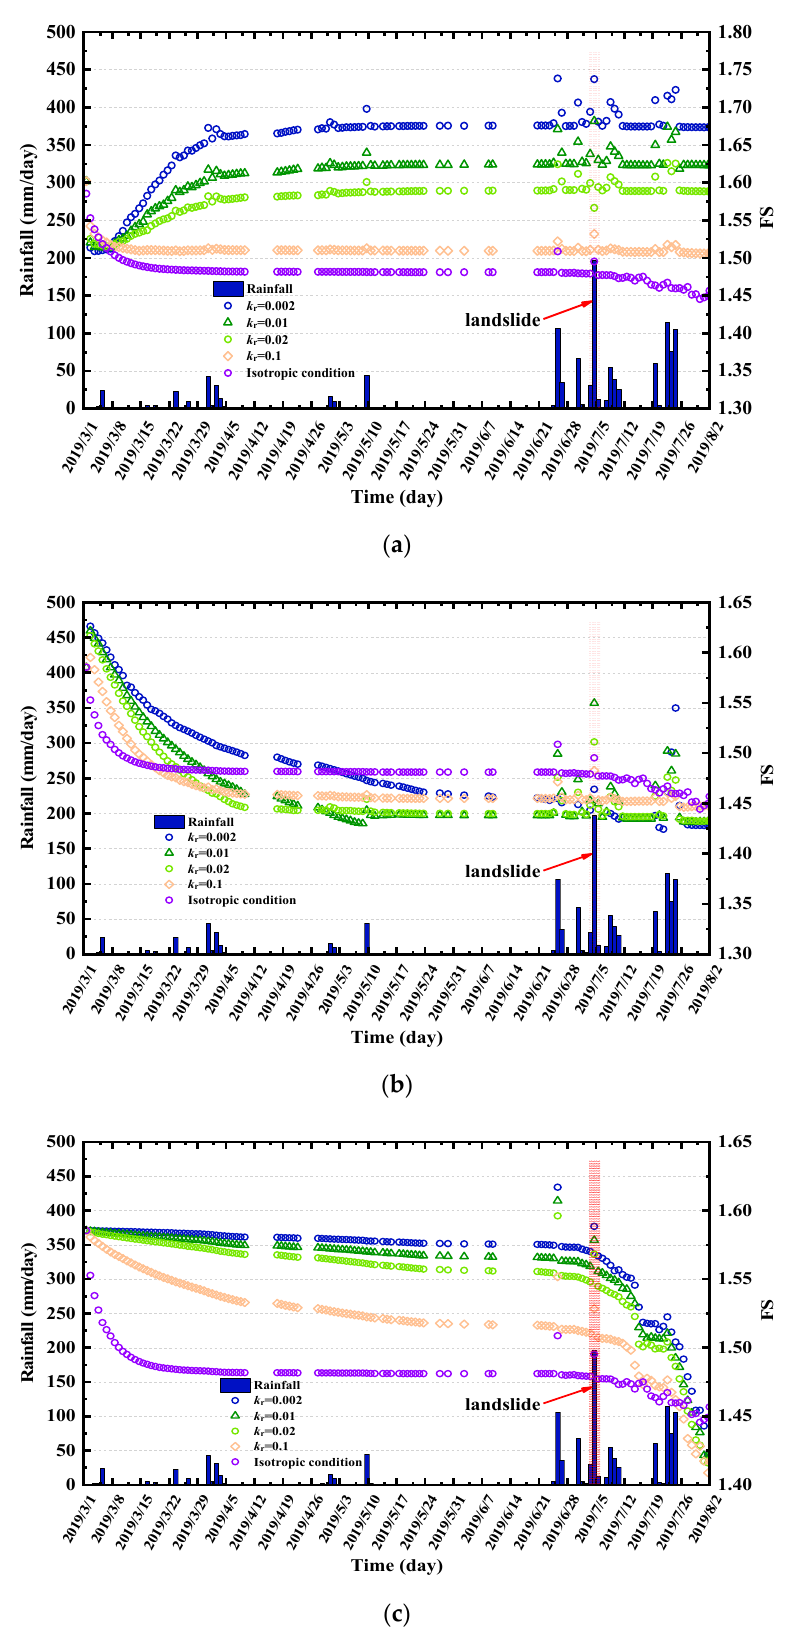
Figure 16. Variations in the safety factors during rainfall under different k r values with β = 0, β = 30, and β = 90°: ( a ) β = 0; ( b ) β = 30; ( c ) β = 90°.